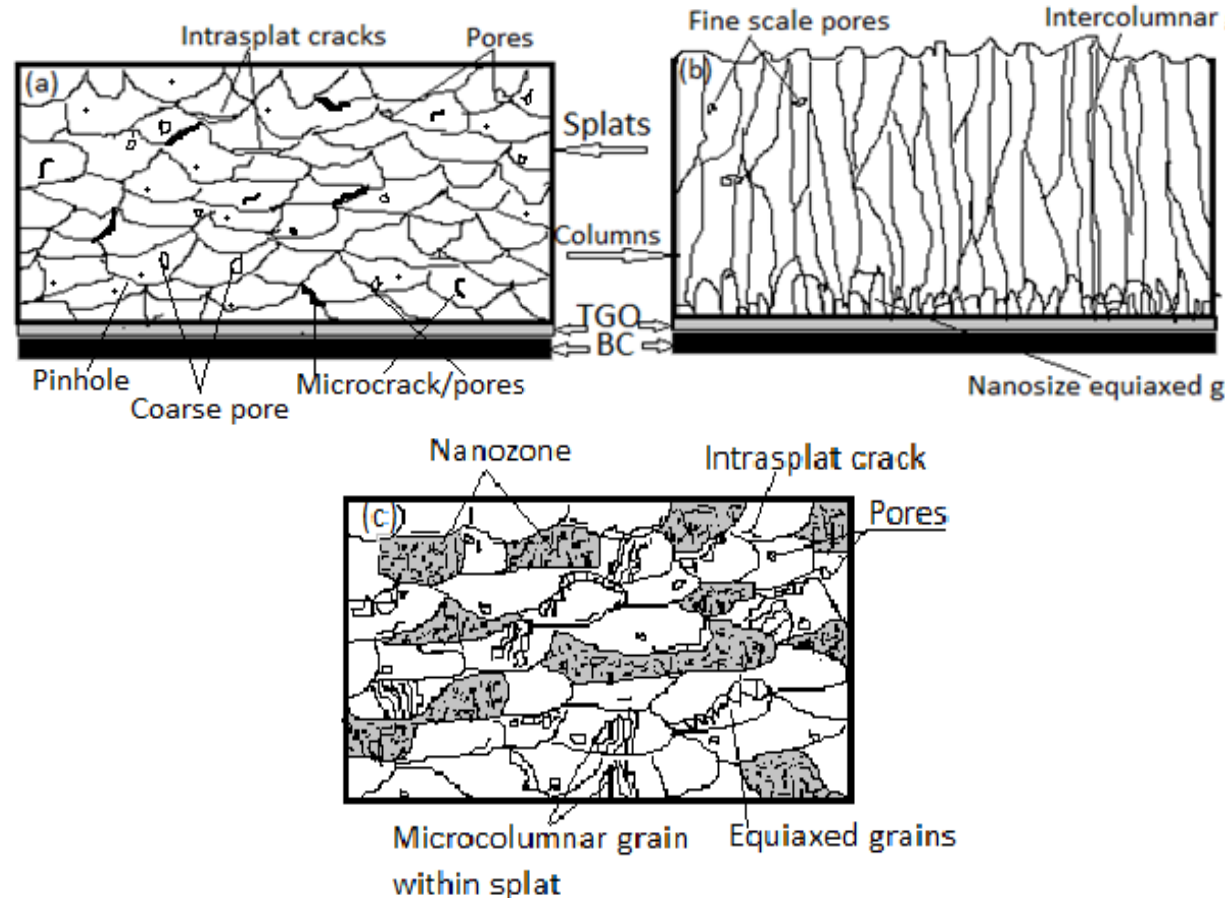
Figure 1. Schematic illustration of as-deposited YSZ microstructures of ( a ) APS micro (conventional) TBC. ( b ) EBPVD- processed TBC and ( c ) APS-nanostructured TBC. The essential features and various defects are displayed and labeled. Two layers (BC and TC) of the TBC arrangement are shown for ( a , b ) with a TGO layer in between, while only the top layer structure is shown for ( c ).